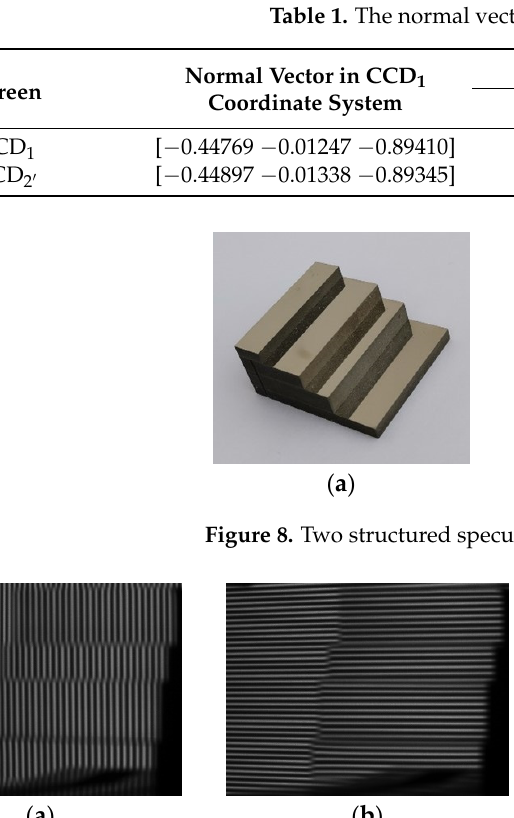
Table 1. The normal vector of LCD screens (units: ° ).